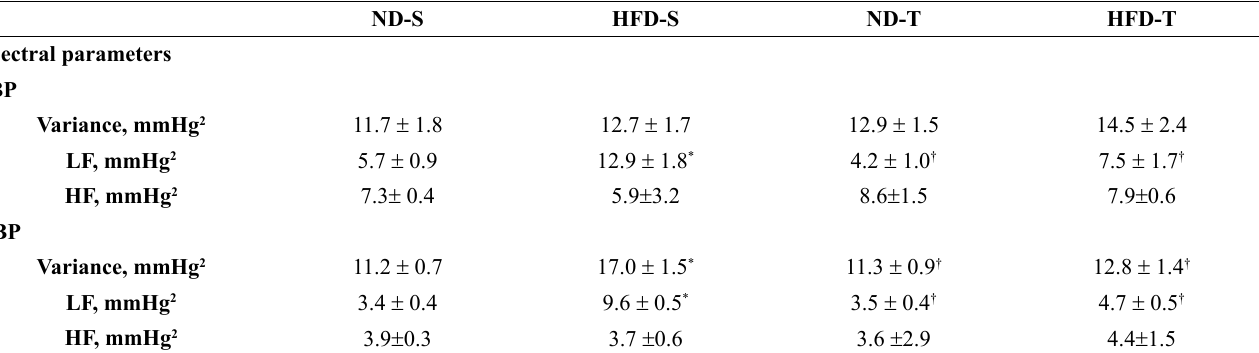
Table 2. Mean values (± SEM) of variance and VLF, LF, and HF spectral components of systolic and diastolic blood pressure variability and pulse interval variability in non-anesthetized Wistar rats submitted to normal diet plus sedentary activity (ND-S, n=8), high-fat diet plus seden- tary activity (HFD-S, n=8), normal diet plus exercise training activity (ND-T, n=8) and high-fat diet plus exercise training activity (HFD-T, n=8) treatment during 9